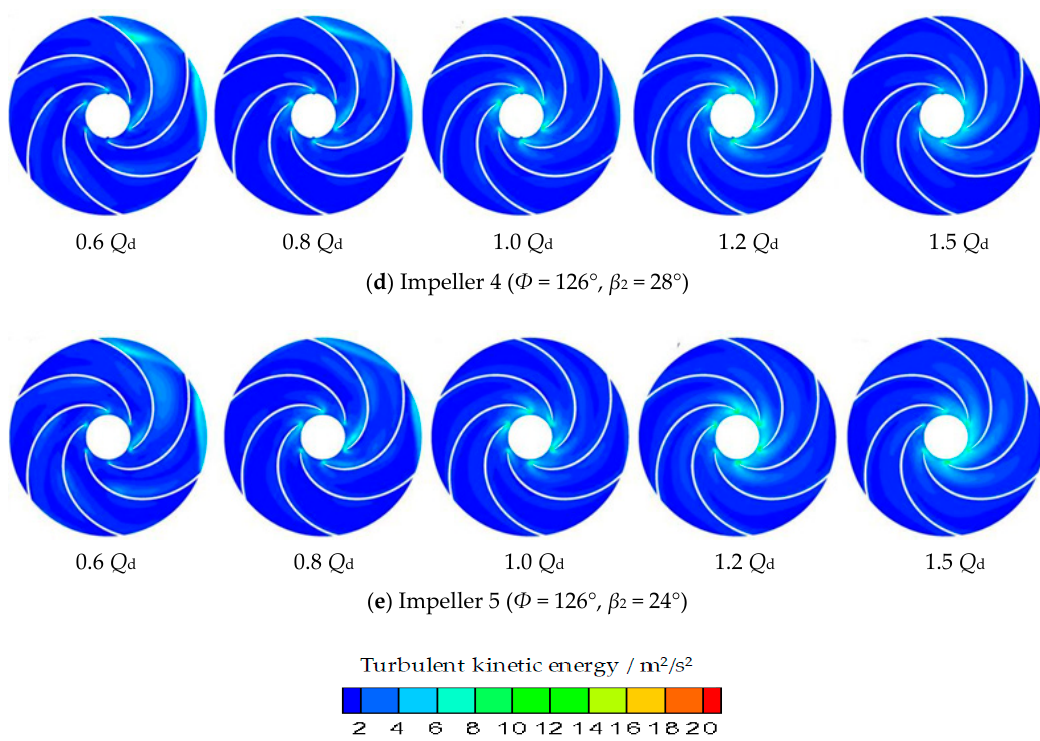
Figure 15. Variation of turbulent kinetic energy in different impellers.